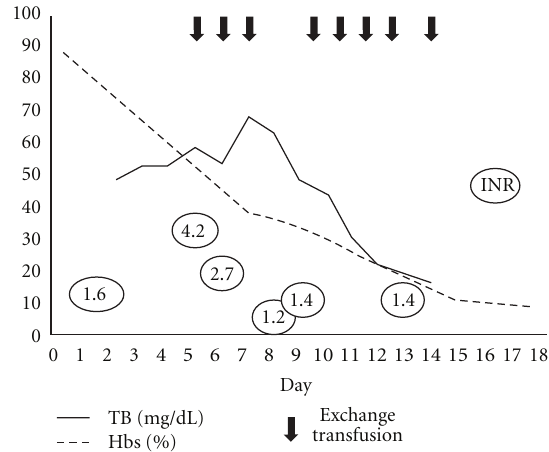
Figure 1: Exchange transfusion and evolution of bilirubin levels, hemoglobin S (HbS) percentage and INR according to the day of hospital